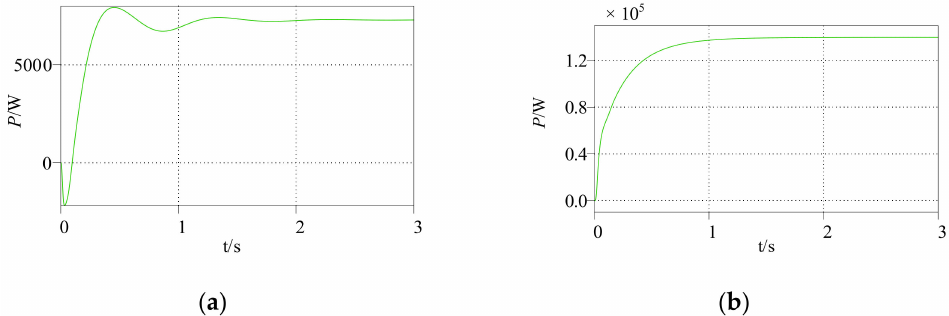
Figure 13. ( a ) Active power of the GFL converter ( P set = 7000 W, SCR = 4.84); ( b ) active power of the GFL converter ( P set = 140,000 W, SCR = 4.84).